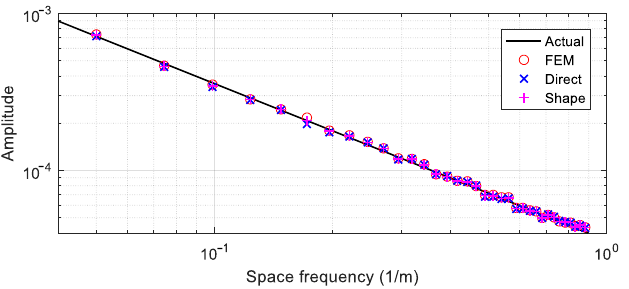
Figure 20. Absolute errors of the estimated road roughness for Case A using sensors S 1 – S 3 .